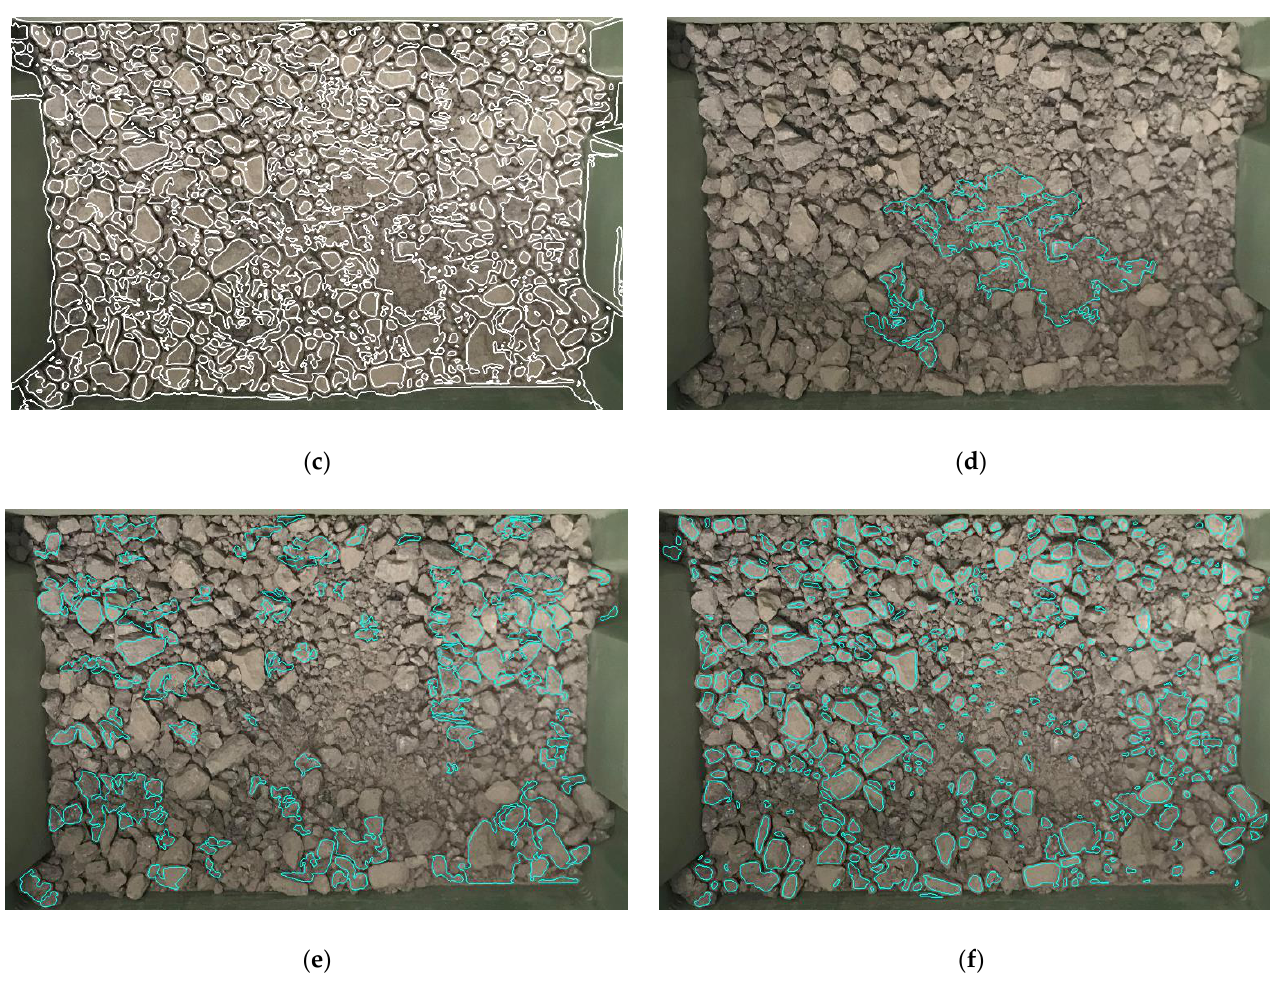
Figure 5. An example of raw image and processed results: ( a ) the raw image; ( b ) the binary image of detected edge; ( c ) all contours found; ( d ) fine region; ( e ) connected rock region; ( f ) single rock